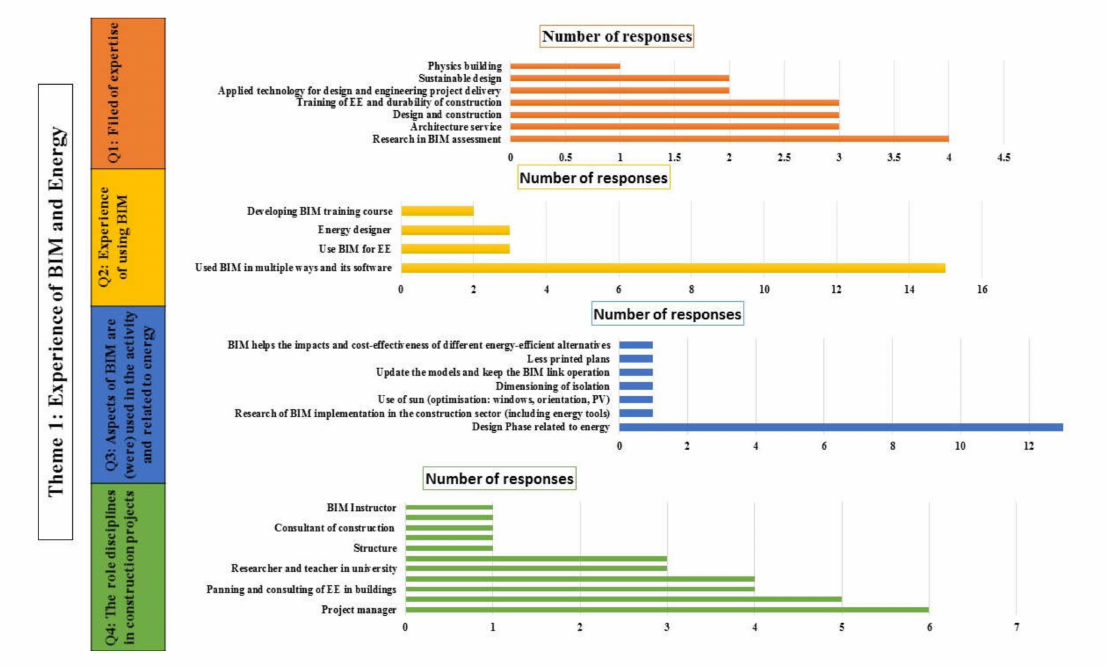
Figure 10. The number of responses for experiences of BIM and